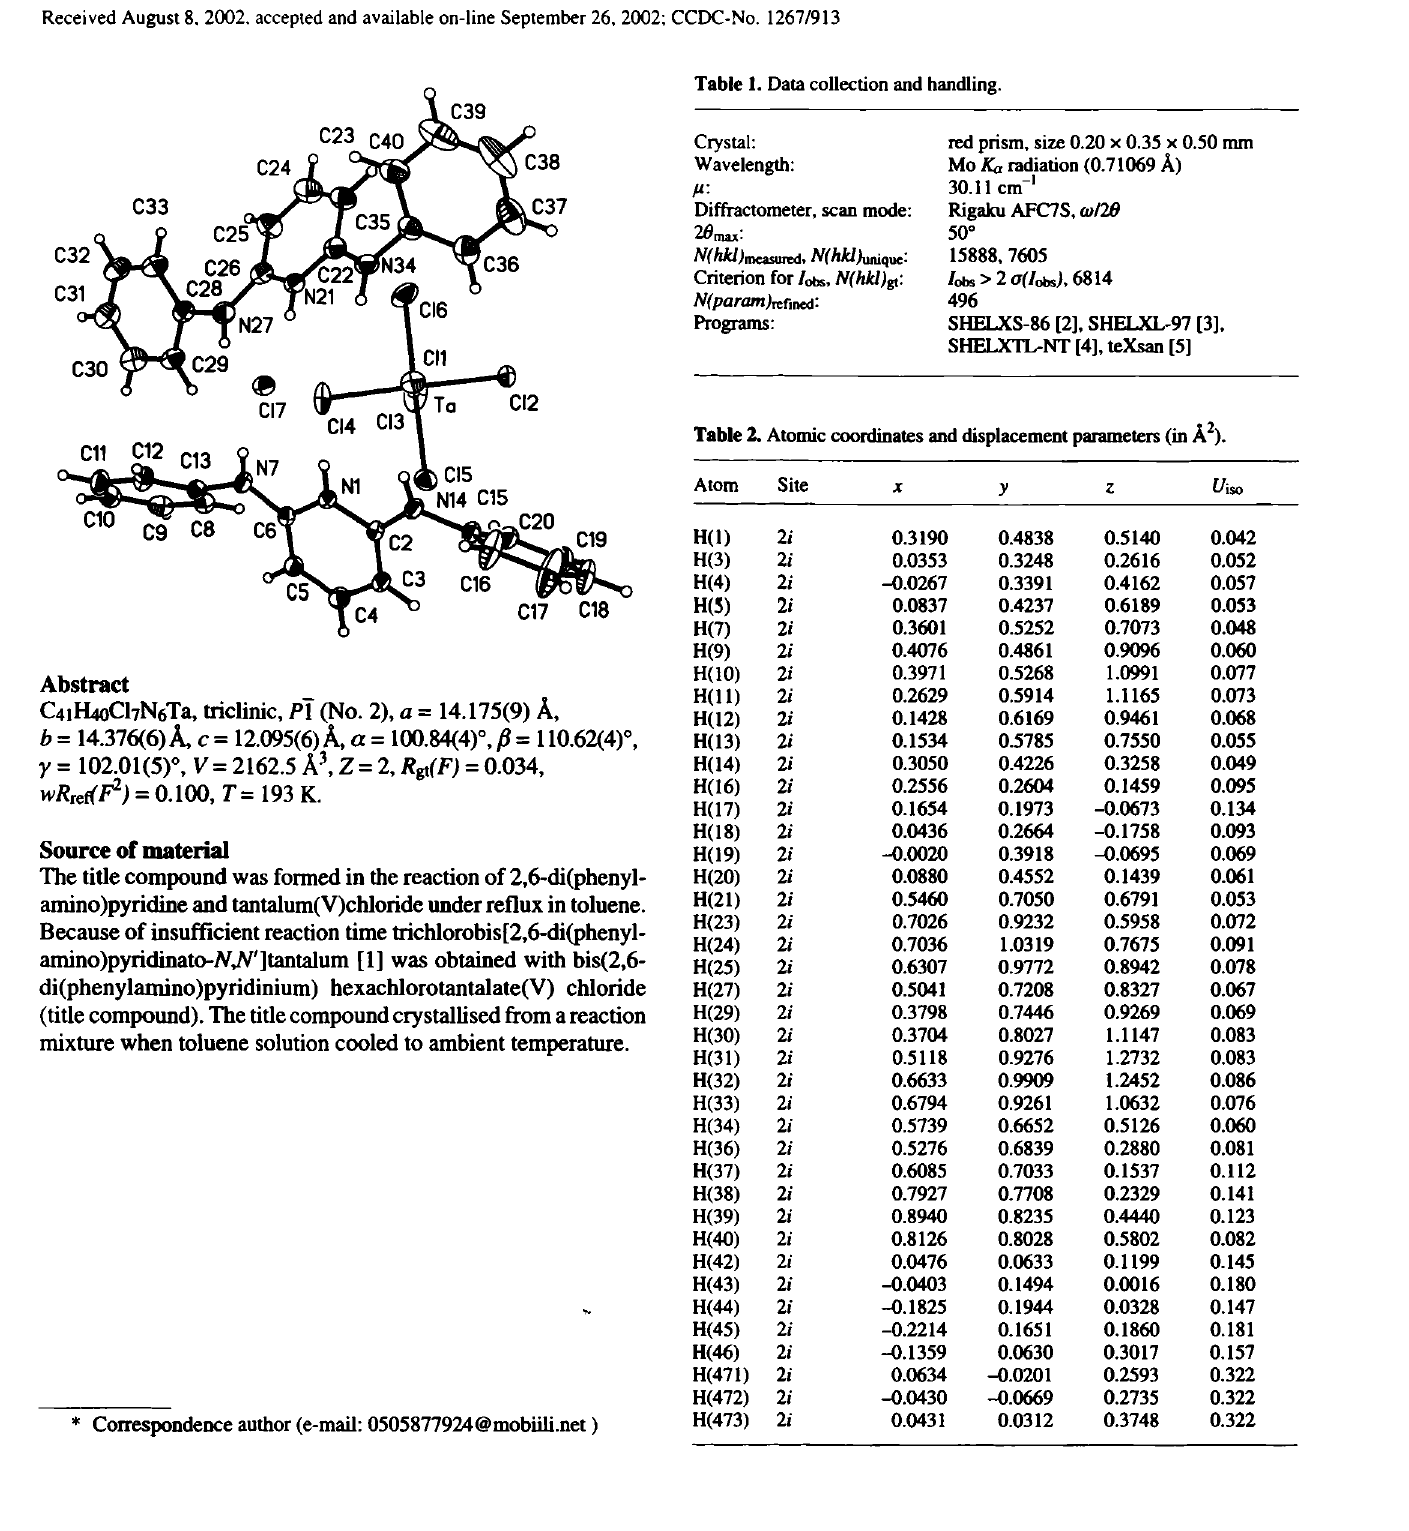
Table 2. Atomic coordinates and displacement parameters (in Â 2